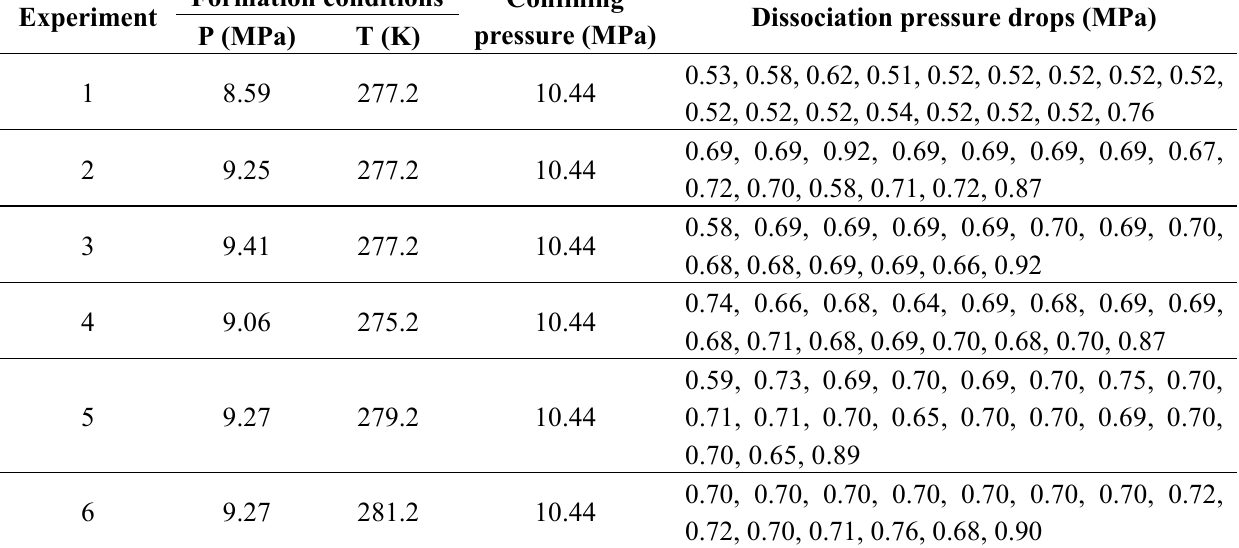
Table 2. Summary of operating conditions utilized in hydrate formation/dissociation experiments with seawater and